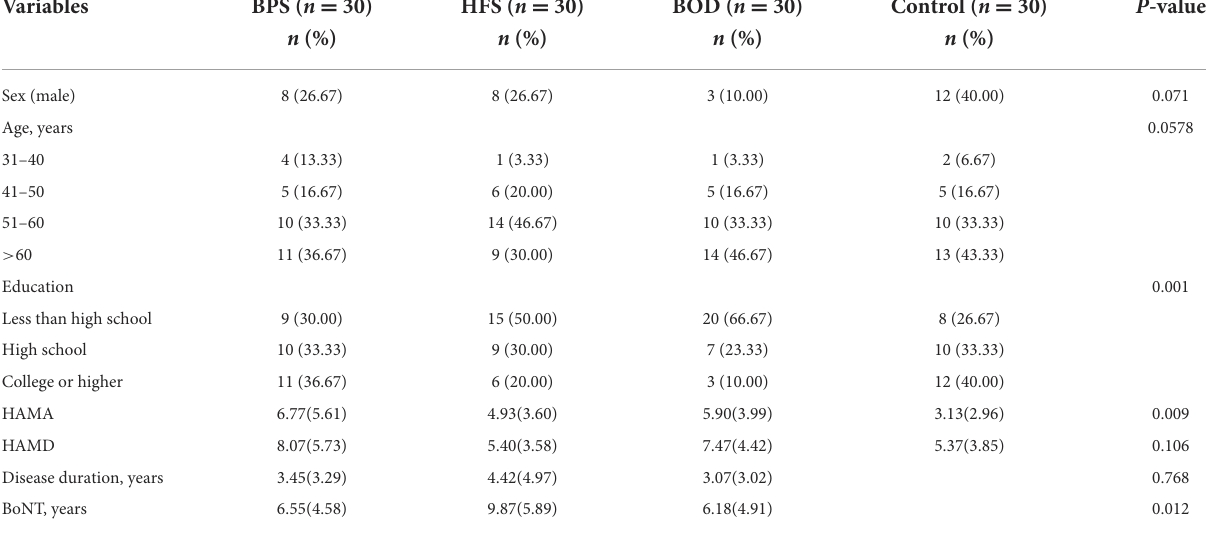
TABLE 1 Participant